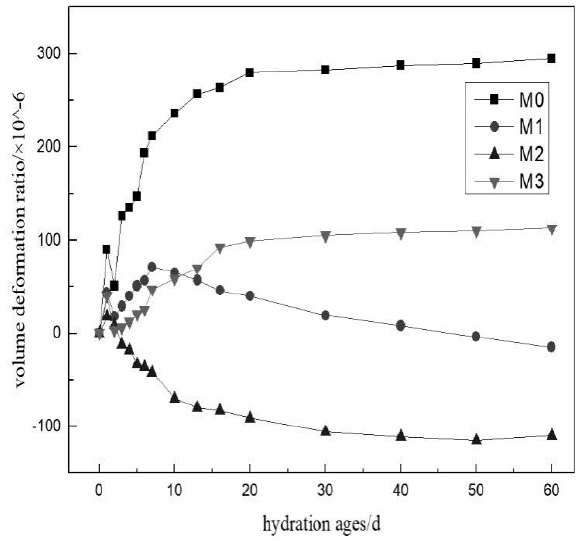
Figure 2. Volume deformation of MKPC hardened paste mixed with mineral materials.